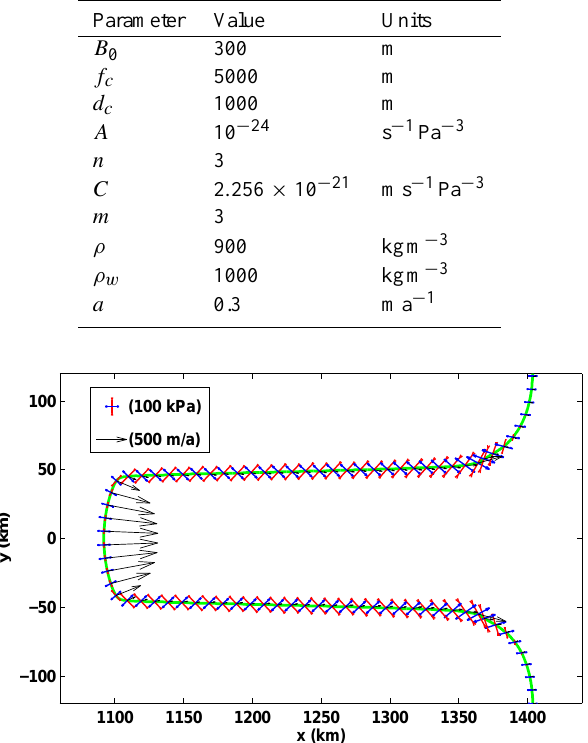
Fig. 1. Principal deviatoric stresses and horizontal velocities along the grounding line for a 100km-wide channel ( w c = 50km). All other model parameters are listed in Table 1. Only a part of the model domain is shown. The overall flow direction is from left to right. Grounding line is shown in green. Ice to the left of the grounding line is grounded (ice stream) and ice to the right of the grounding line is afloat (ice shelf). Tensile stresses are shown in blue and compressive stresses in red. Bed slopes are retrograde for 973 . 7km < x < 1265 . 7km.